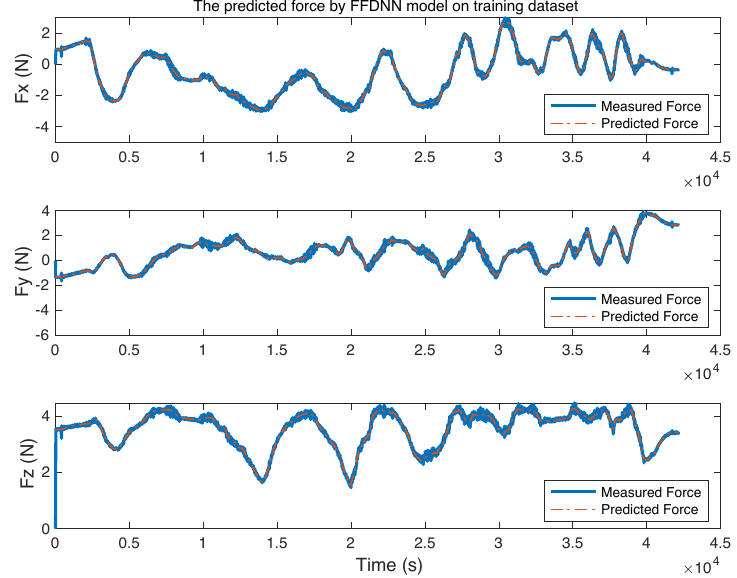
Figure 10. The predicted force of M1 model on the training dataset.